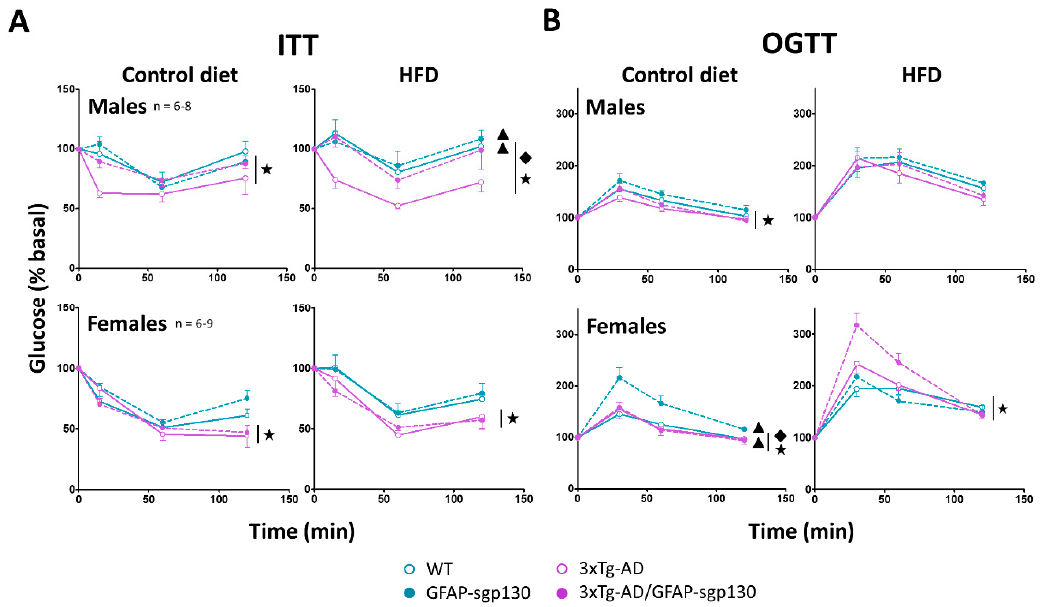
Figure 5. Insulin tolerance test (ITT) and oral glucose tolerance test (OGTT) at both experimental phases. ( A ) 3xTg-AD mice showed hypersensitivity to insulin in both control and HFD phases, which was reverted by the inhibition of IL-6 trans-signaling in males during the HFD phase. ( B ) In the control phase, the 3xTg-AD mice tended to have better glucose tolerance, whereas in the HFD phase results were not clear-cut; this was also the case regarding the effect of sgp130Fc. Results are MEAN ± SEM. ★ p ≤ 0.05 vs. 3xTg-AD negative; ▲ p ≤ 0.05 vs. sgp130Fc negative; ◆ Indicates a significant interaction between both factors.